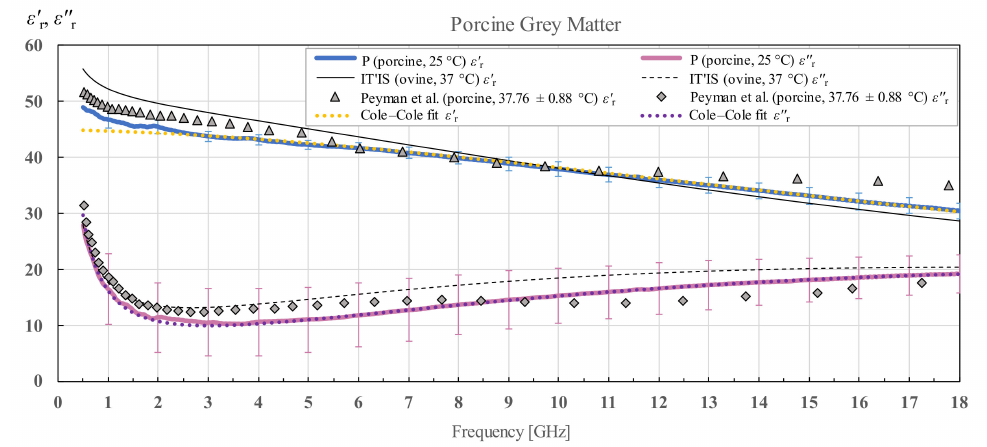
Figure 17. Permittivity of porcine grey matter (P) with standard deviation and Cole–Cole fit, shown in comparison with the data from IT’IS database [21] and Peyman et al.